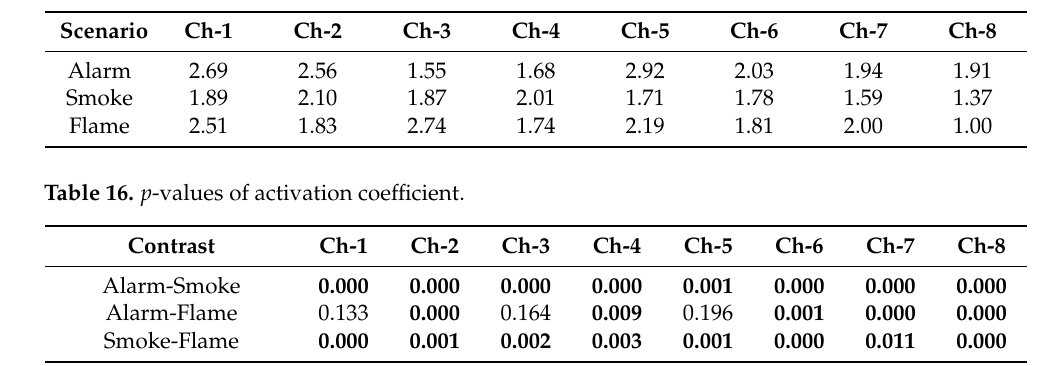
Table 15. Standard deviations of activation coefficient.